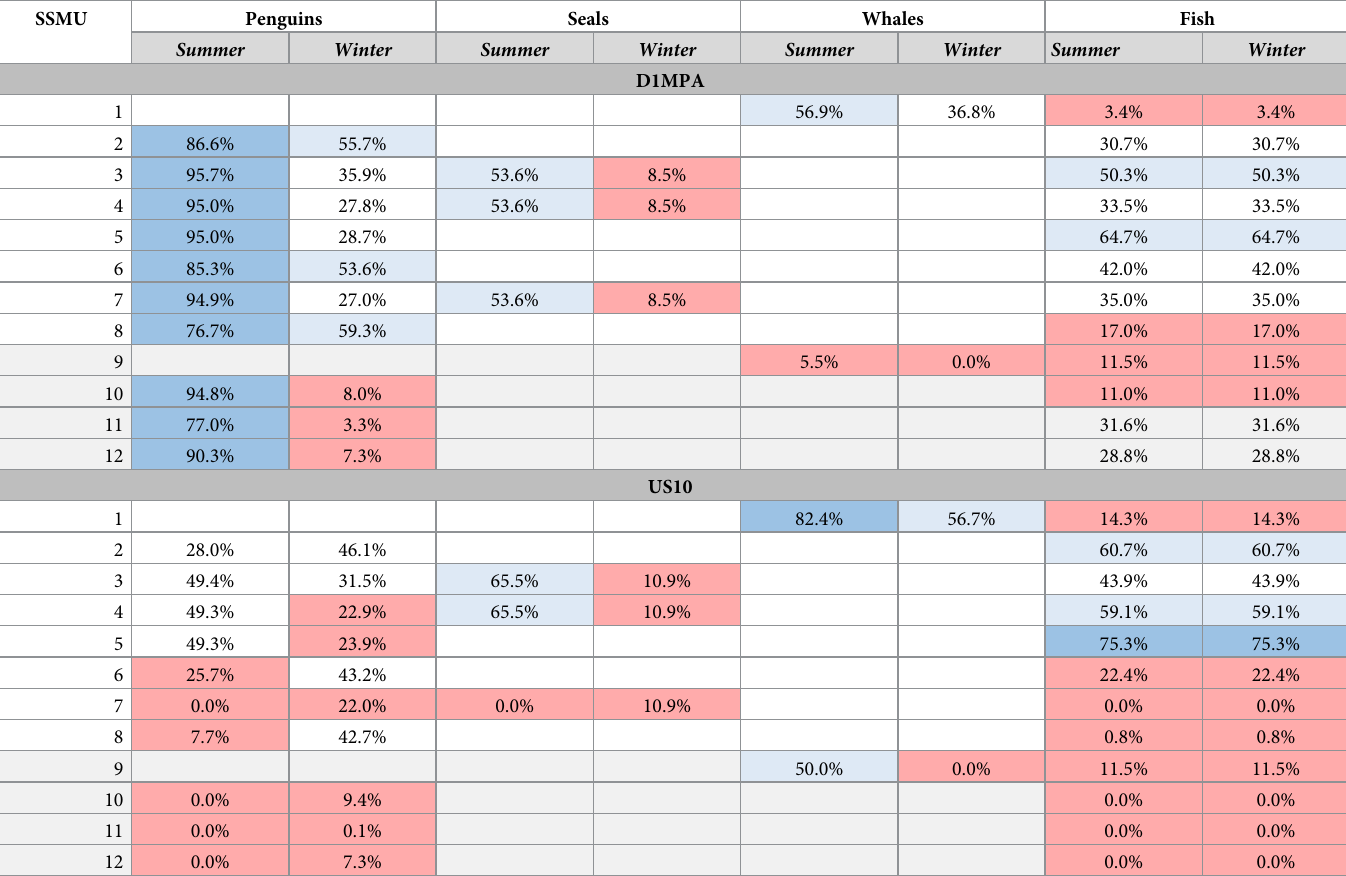
Table 1. SSMU-specific, seasonal percentages of the total krill a predator group demands for that season (i.e. foraging percentages) from areas closed to fishing in each of the two MPA